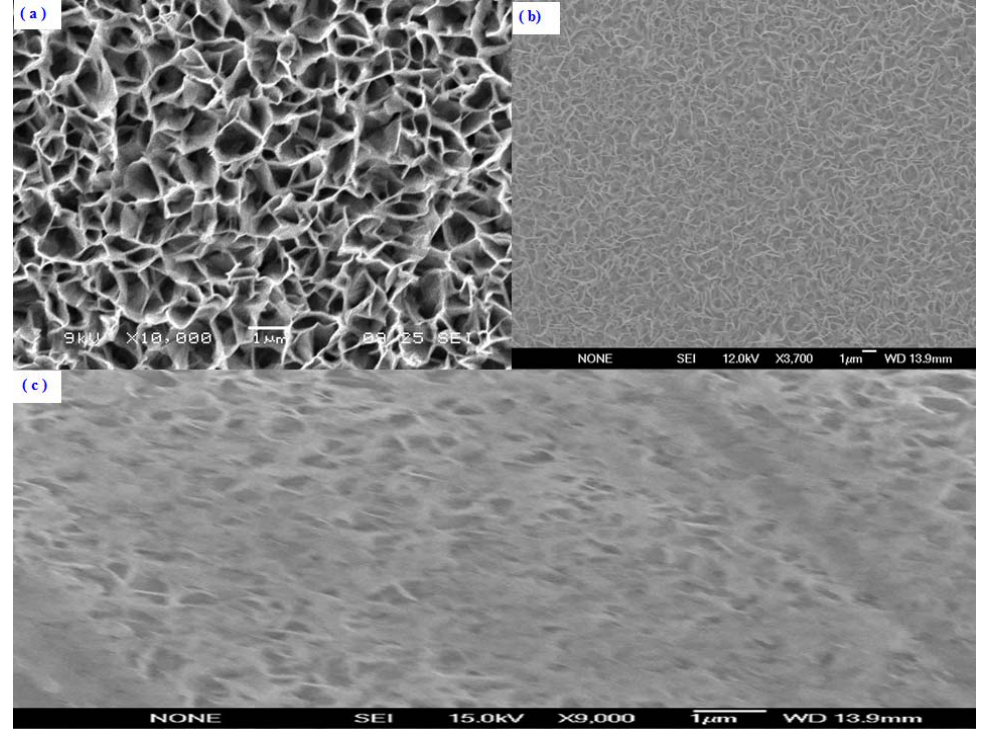
Figure 2. A typical SEM images of ZnO-NFs arrays grown on gold coated glass